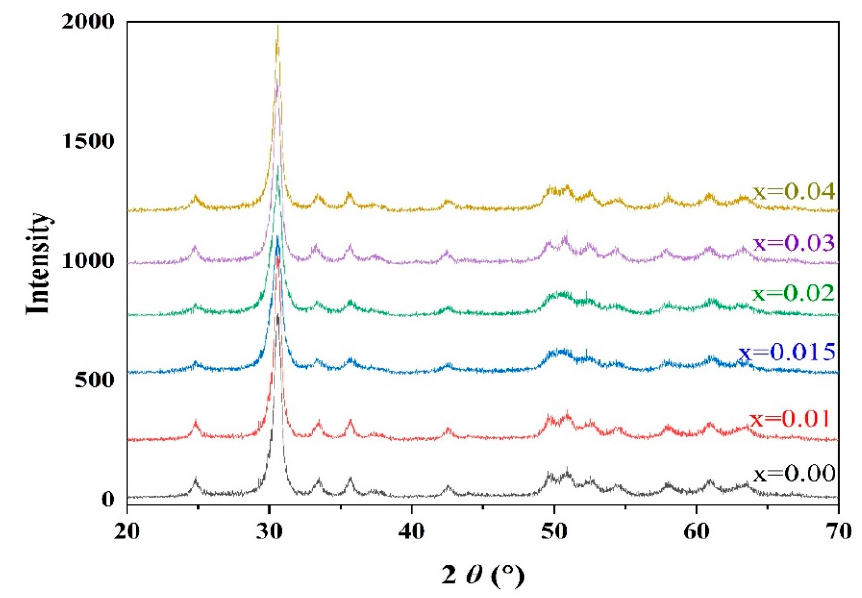
Figure 2. XRD patterns of ZT powders synthesized at 740